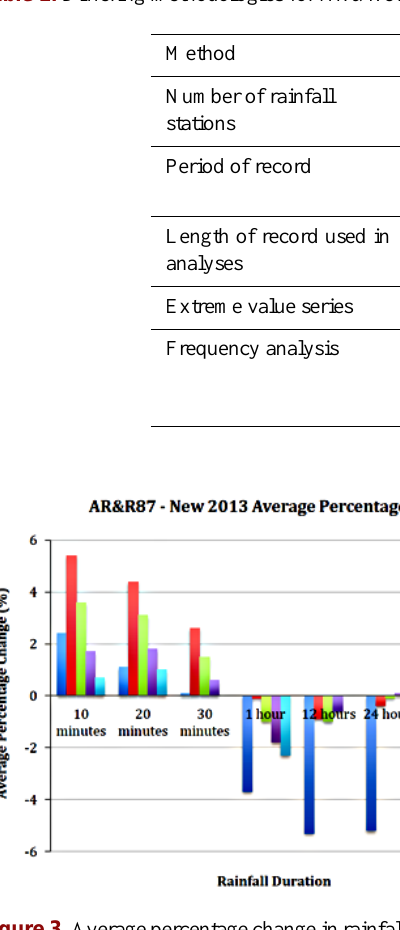
Figure 3. Average percentage change in rainfall intensities between AR&R87 and 2013 update.